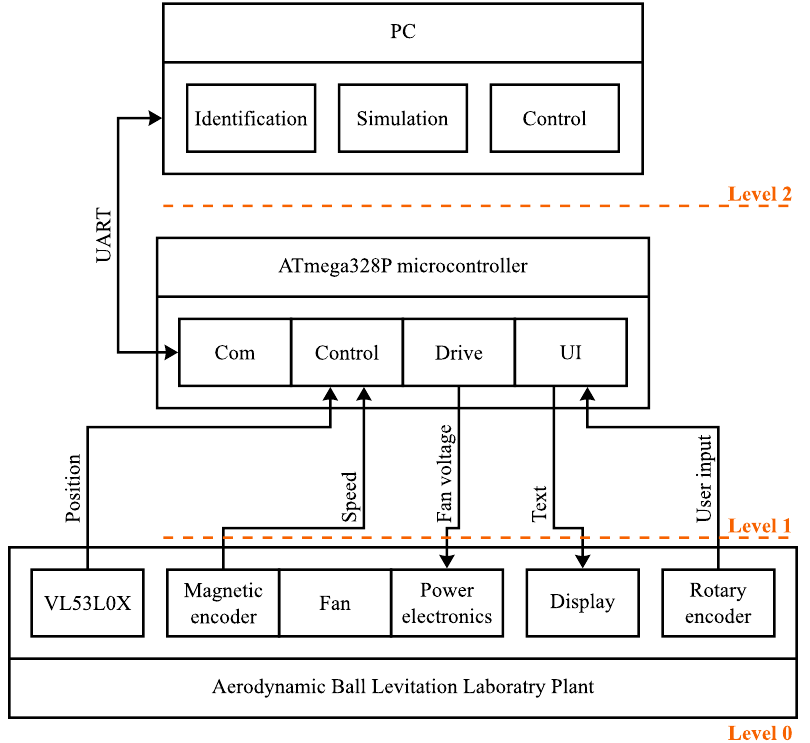
Figure 16. Implementation of the DCS architecture for the Aerodynamic Ball Levitation Labora- tory